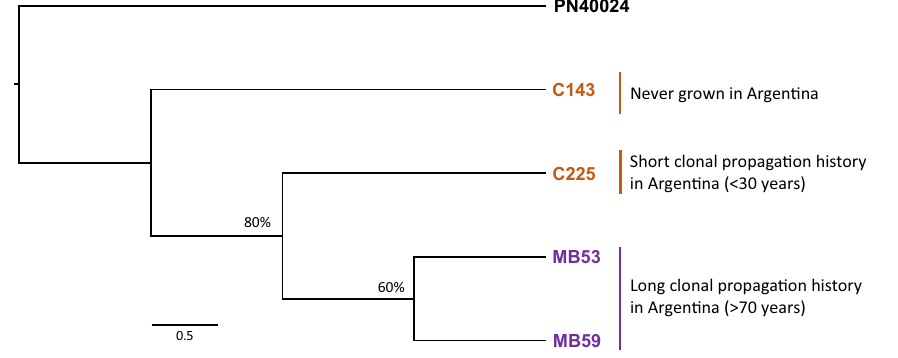
Figure 2. Phylogenetic relations among four resequenced Malbec accessions. Neighbor-joining tree based on p -distances and employing 941 SNVs. Percentages on the nodes represent bootstrap supports after 200 iterations, values > 50% are shown. The PN40024 genotype was used as